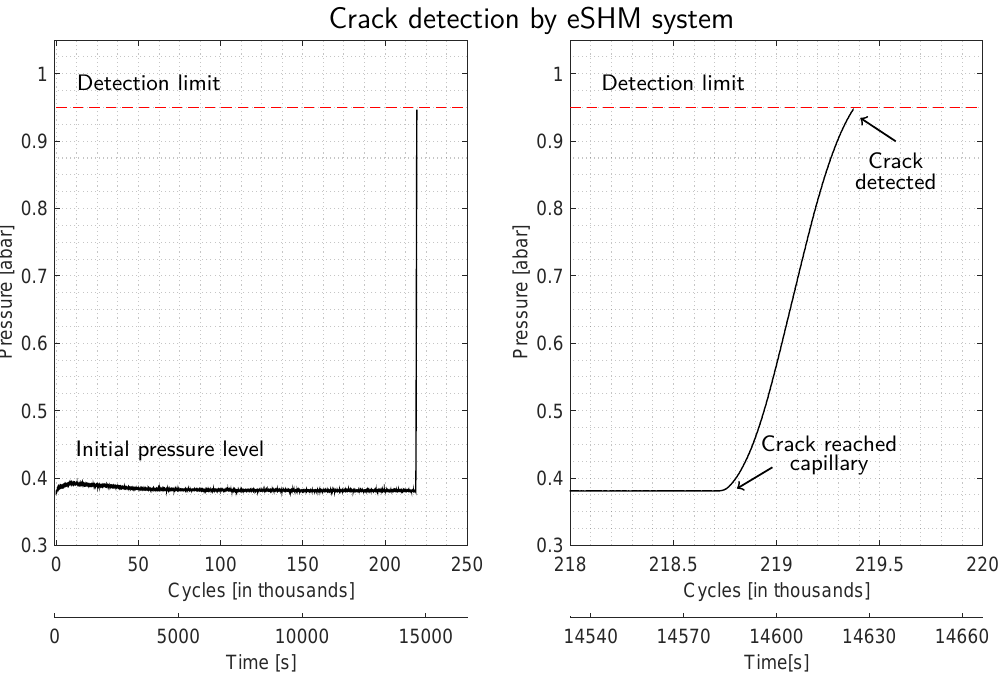
Figure 4. Crack detection by eSHM system for Specimen 13. Capillary pressure output during the entire test ( left ) and a detailed view on crack detection ( right